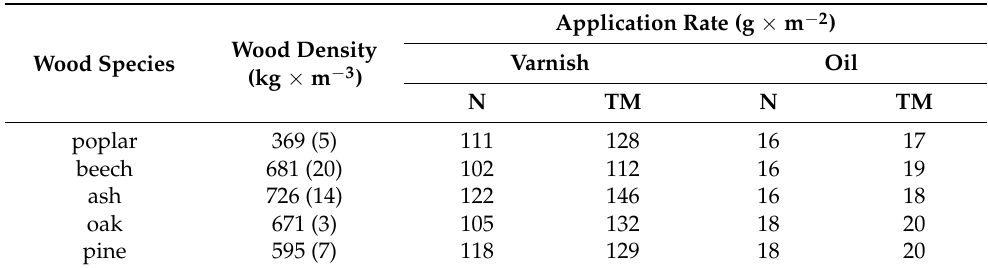
Table 2. Native wood density (standard deviation in parentheses), the application rate of agents.